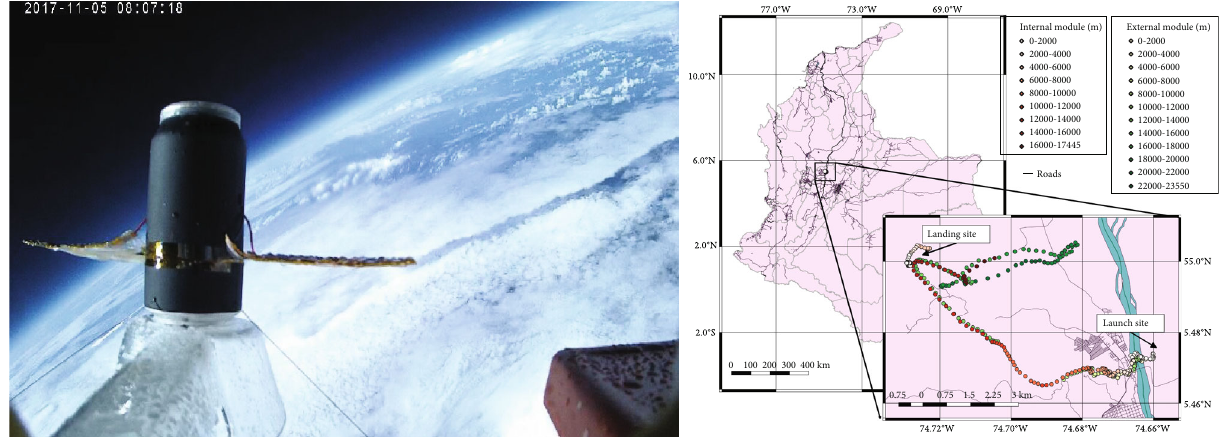
Figure 16: External CanSat S2-2 in the stratosphere just before the descent and location of the launching and splashdown site of the high- altitude